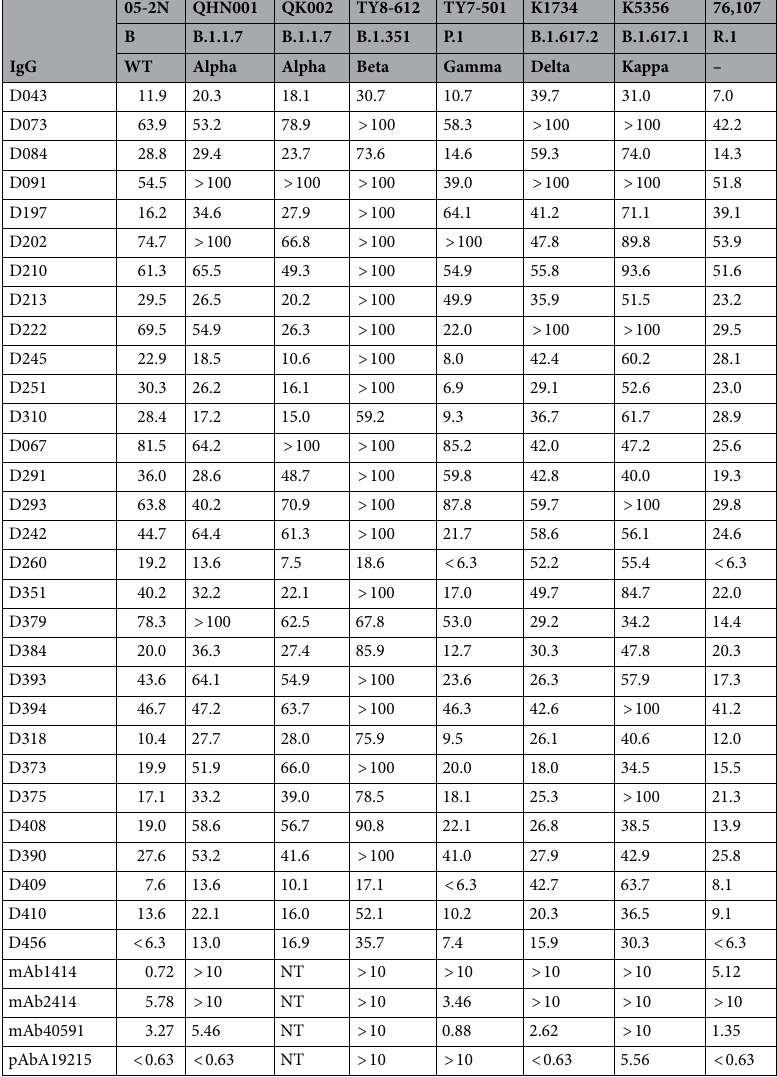
Table 1. Convalescent plasma antiviral activity of IgGs in VeroE6 TMPRSS2 . Data are IC 50 (µg/ml)